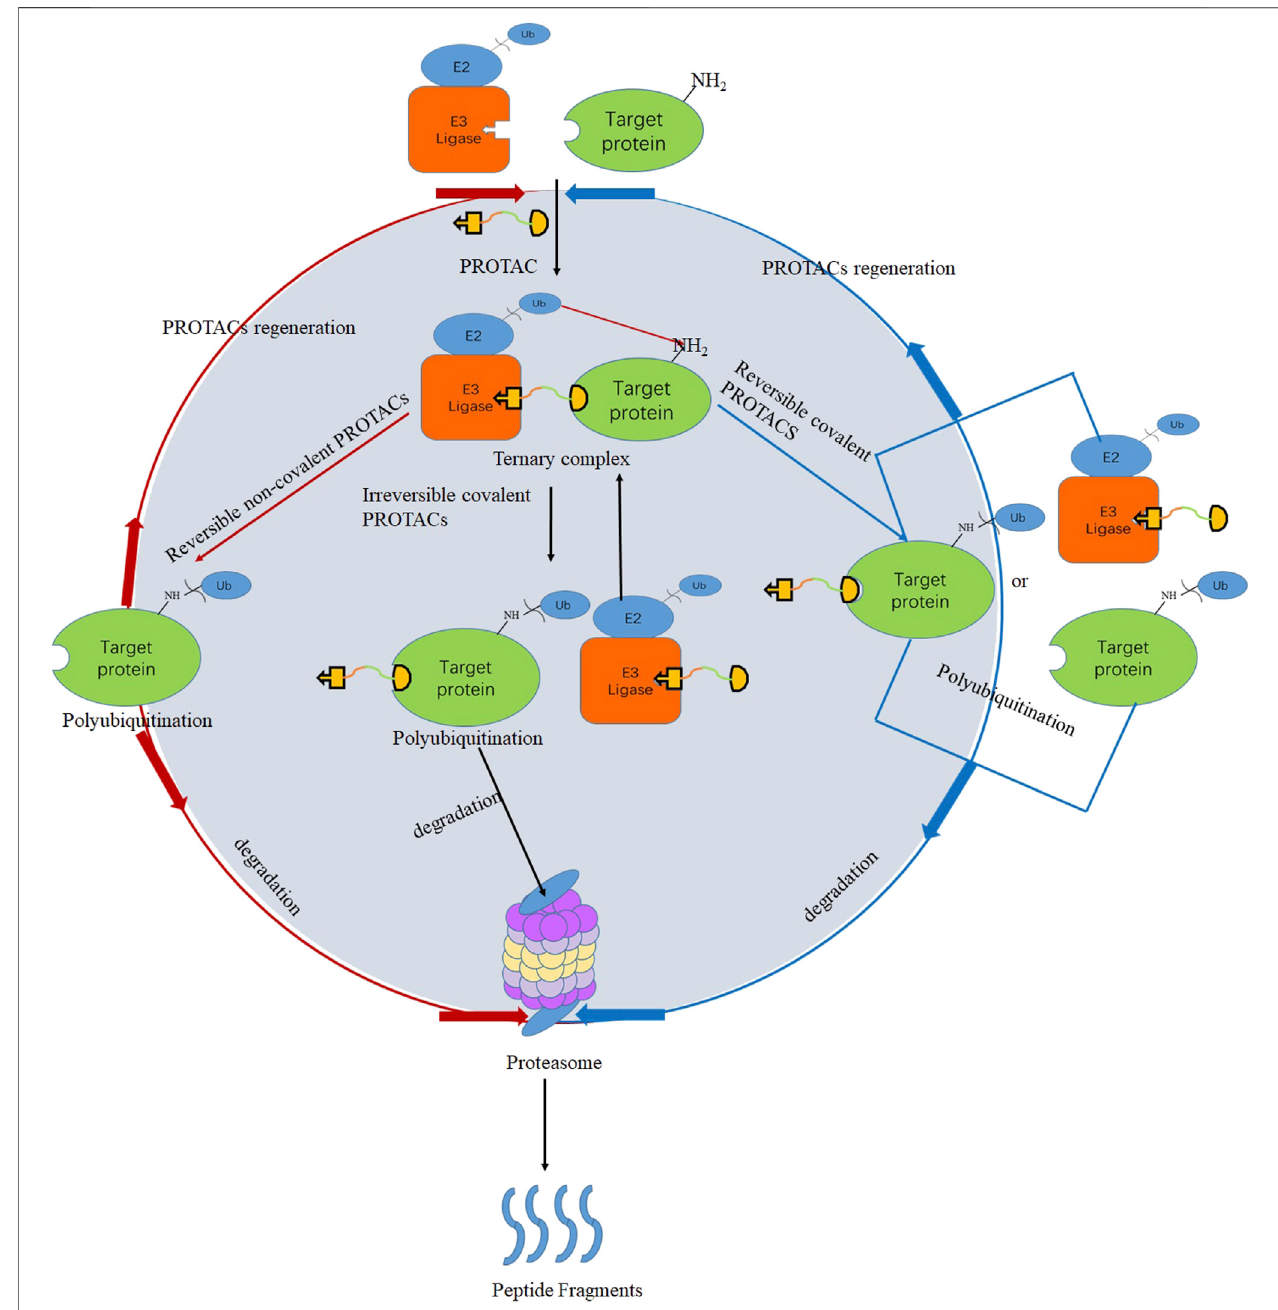
FIGURE 1 | PROTACs ’ mechanism for irreversible covalent PROTACs (black), reversible covalent PROTACs (blue), and reversible noncovalent PROTACs (red).